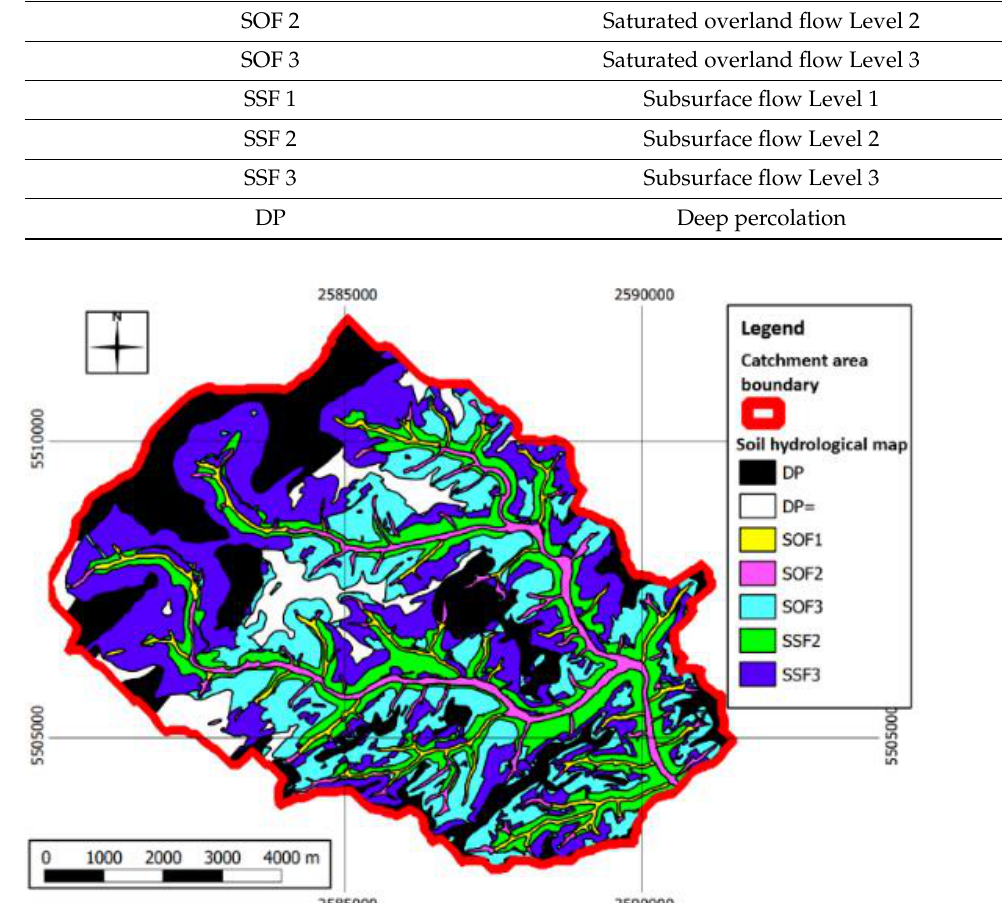
Figure 2. Reference soil hydrological map—spatial distribution of DRPs in the catchment area Kronweiler [48].